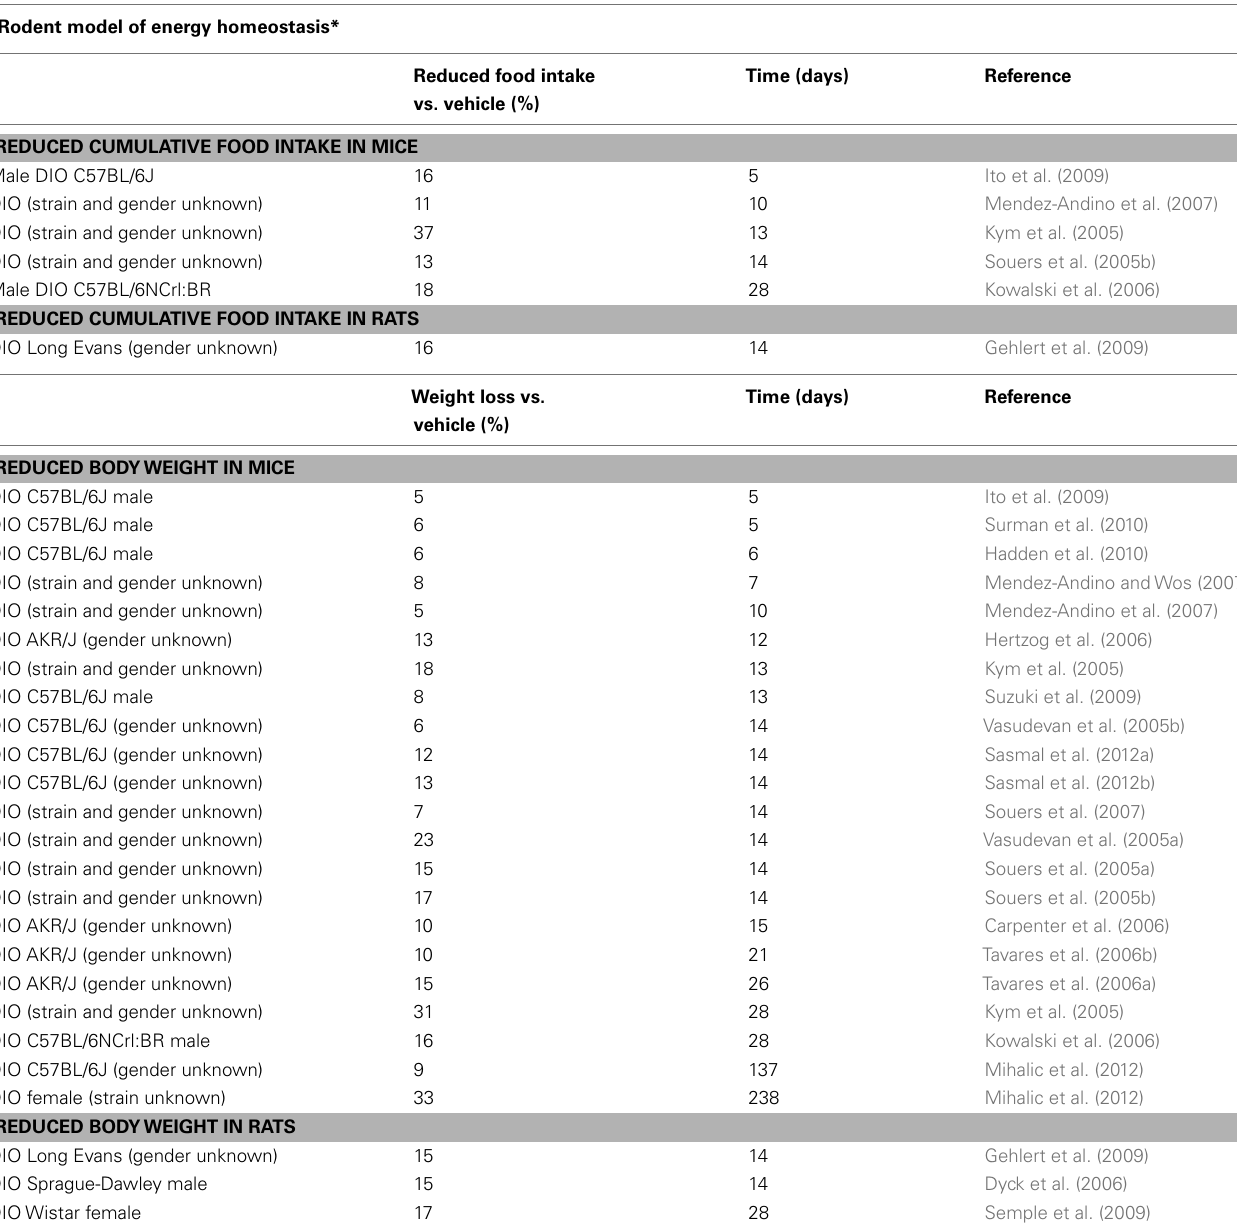
Table 3 | Chronic effects of non-peptide MCH1R antagonists in